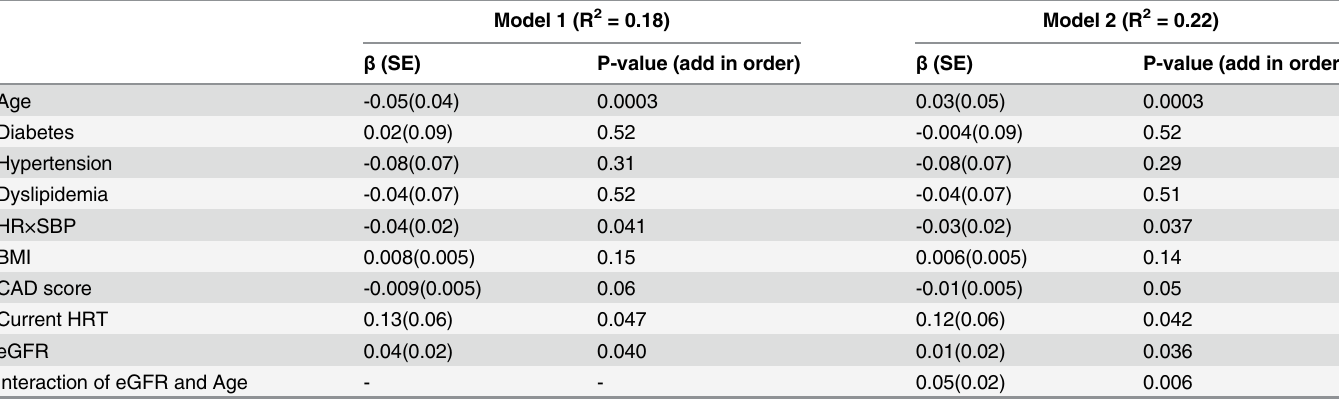
Table 2. Independent predictors of coronary flow reserve